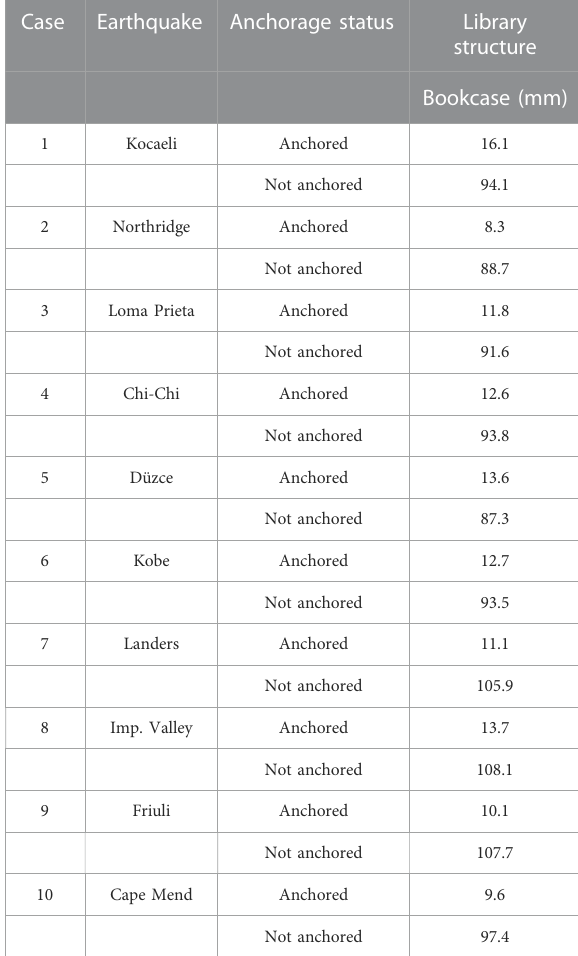
TABLE 7 Maximum seismic displacement results for different NEs (Cavuslu, 2022).